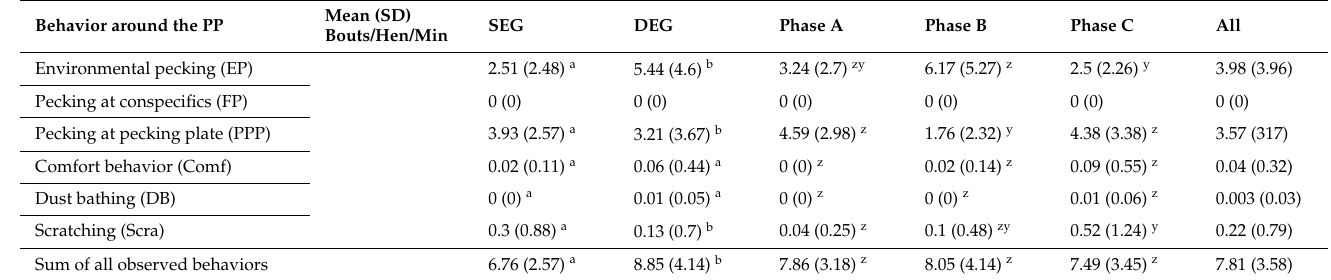
Table 6. Mean and standard deviation (SD) of the different behaviors observed per minute and hen around the enrichment device in two groups (SEG = single enrichment group, DEG = double enrichment group) and different phases during production (Phase A: peak of laying period, weeks of life (LWs) 31/32; Phase B: middle of laying period, LWs 50/51; Phase C: end of laying period, LWs